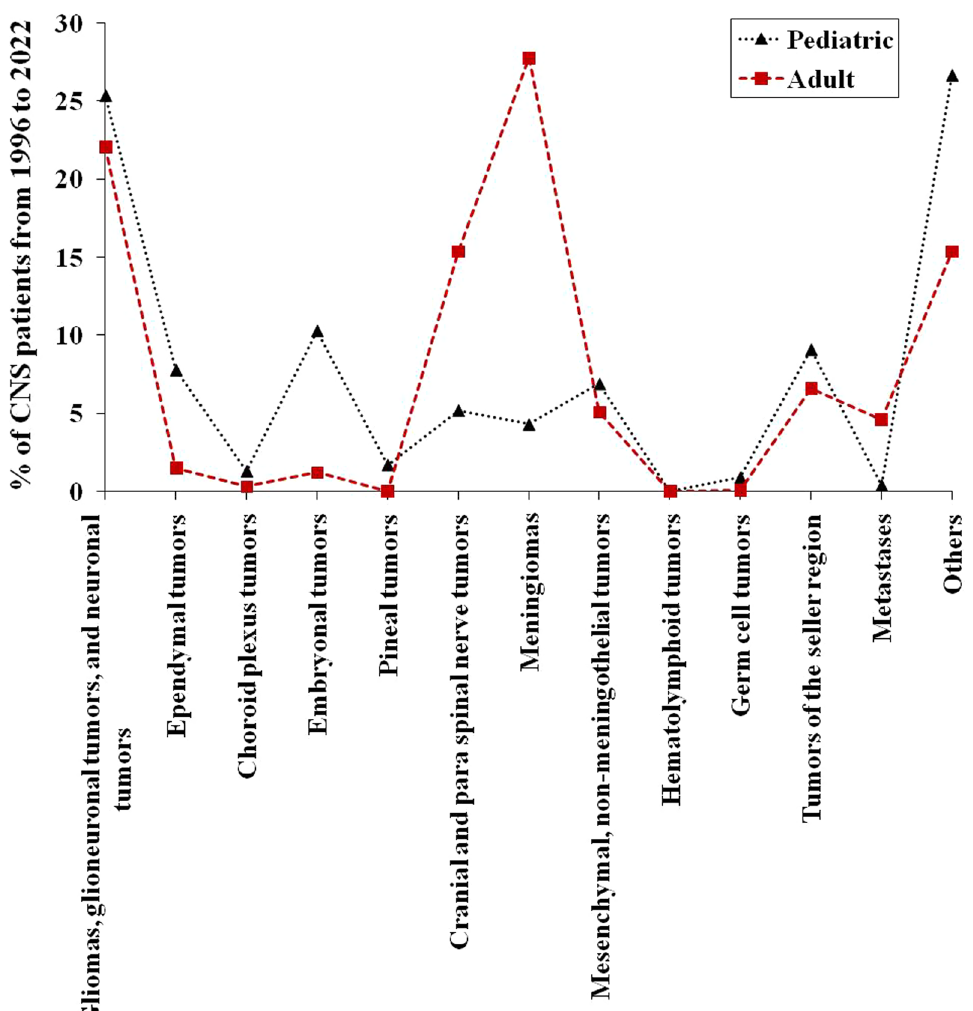
Fig. 1 Histological distribution of CNS cases in pediatric and adult